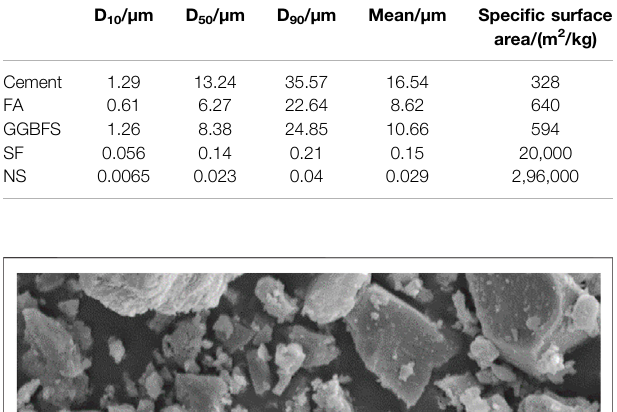
FIGURE 2 | SEM images of cement and SCMs, fl y ash.